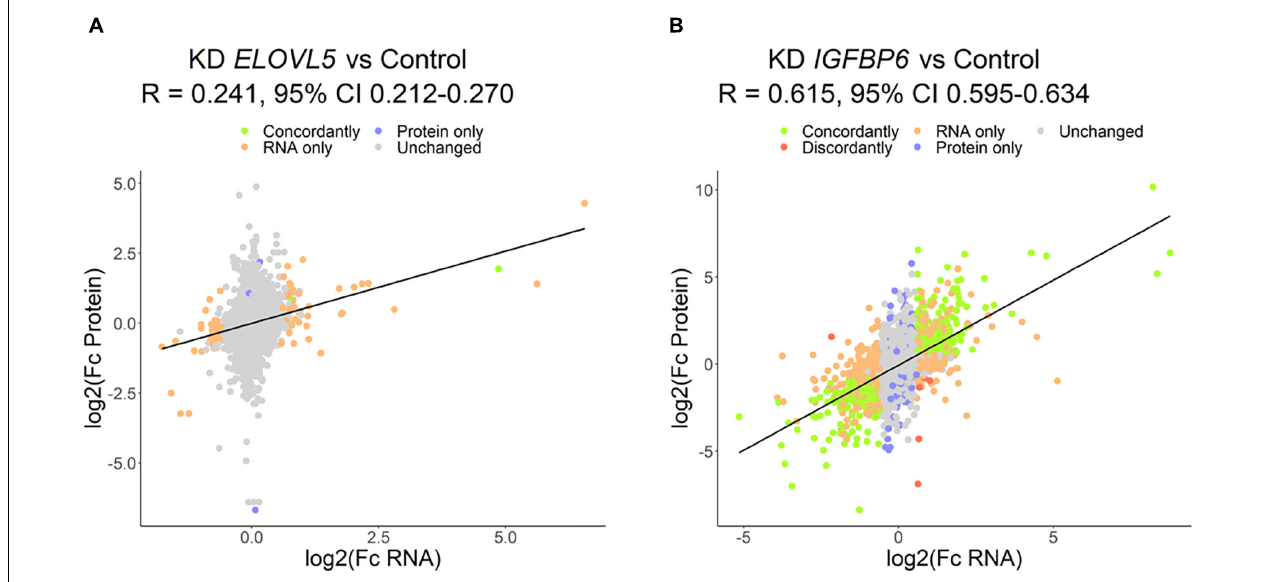
FIGURE 9 | Correlation of the results of proteomic and transcriptomic analysis of the cells with a stable knockdown of the (A) ELOVL5 and (B) IGFBP6 genes. TABLE 3 | Selected enriched biological processes for the proteins with a significantly changed expression after knockdown of the IGFBP6 gene. The proteins with decreased expression The proteins with increased expression GO ID Biological processes GO